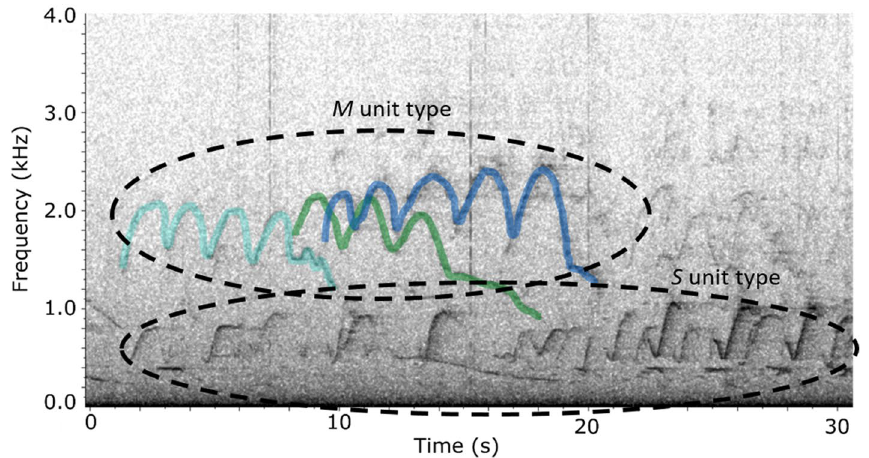
Figure 2. Spectrogram screenshot of an example of 3 bowhead whales sharing similar songs, recorded on the 10th of December 2013. The 3 Units M are shown in colour to highlight their overlap in